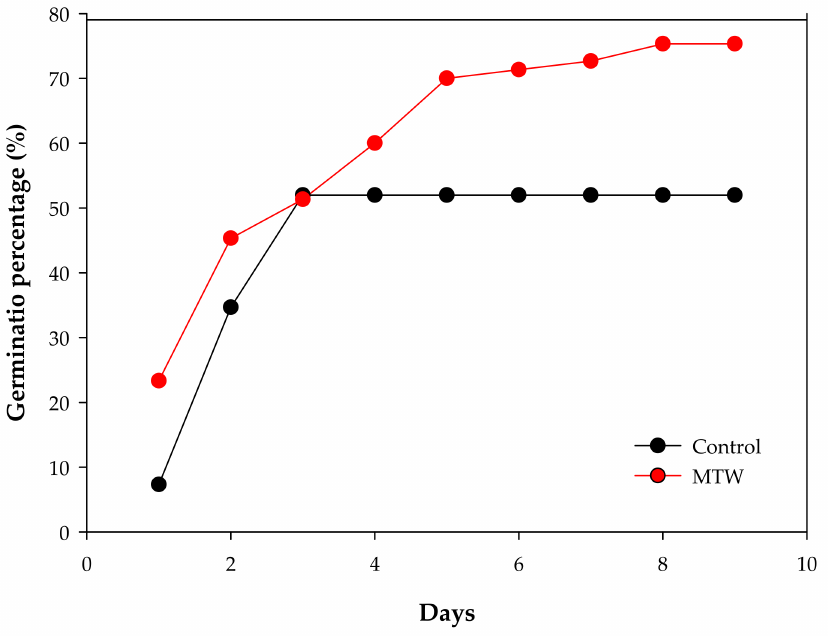
Figure 1. Germination percentage of Phaseolus vulgaris L. grown with magnetically treated water ( p < 0.05). Control: plants grown without magnetically treated water, MTW: plants grown with magnetically treated water under a static magnetic field between 100 and 160 mT.